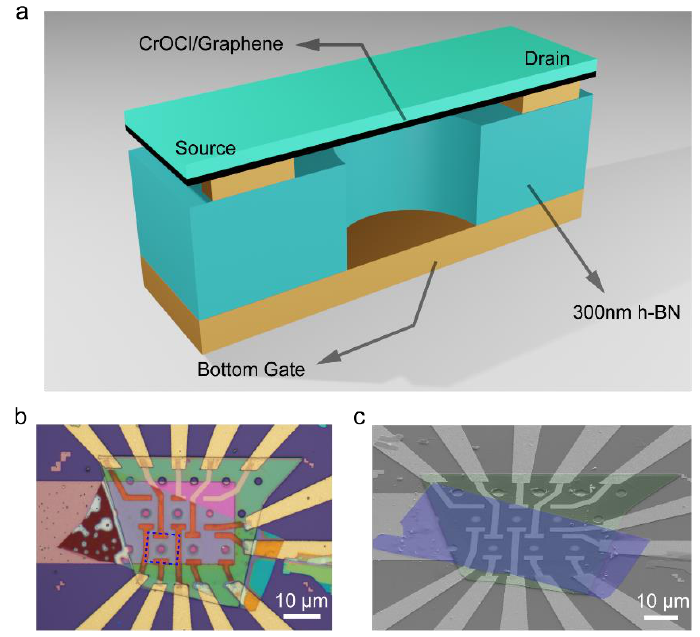
Figure 1. The suspended CrOCl/graphene heterostructure resonators. ( a ) Schematic diagram of the fabricated CrOCl drum resonators (cross-section view). ( b ) Optical image of CrOCl resonators. ( c ) SEM image of the device in ( b ), which confirms that the CrOCl/graphene drums are suspended well. Suspended CrOCl/graphene heterostructure and holed h-BN were marked in purple and green boxes, respectively.